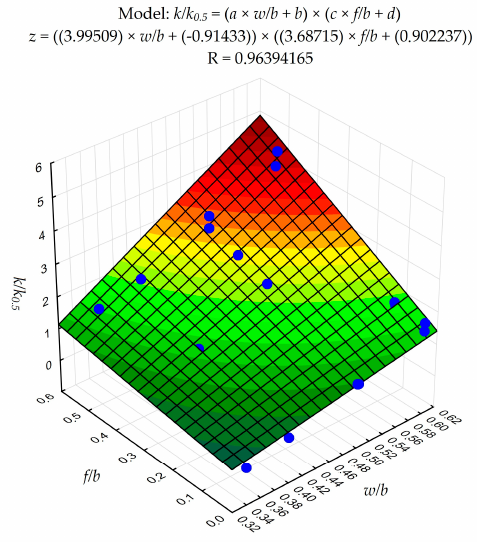
Figure 1. Carbonation coefficients k / k 0.5 model plotted against w / b and f / b with best regression for fly ash concrete.